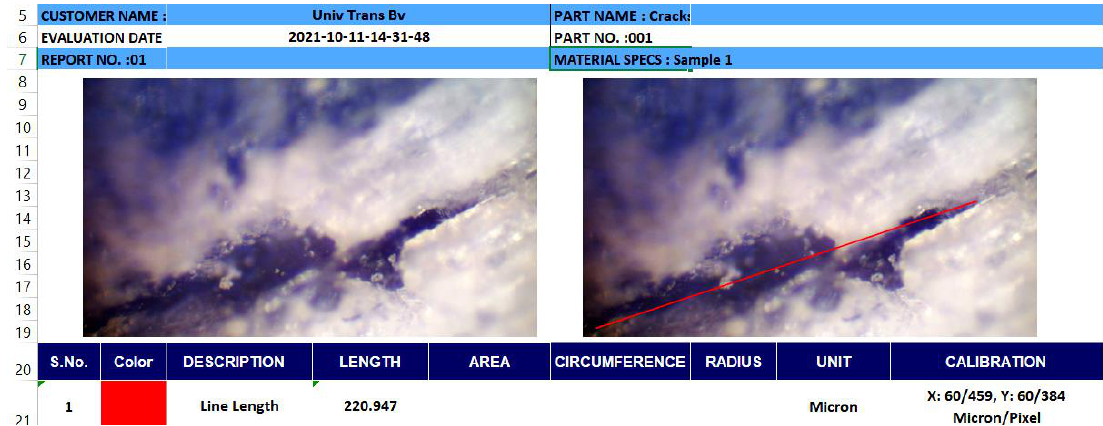
Figure 5. Crack measurement with Material Plus software.